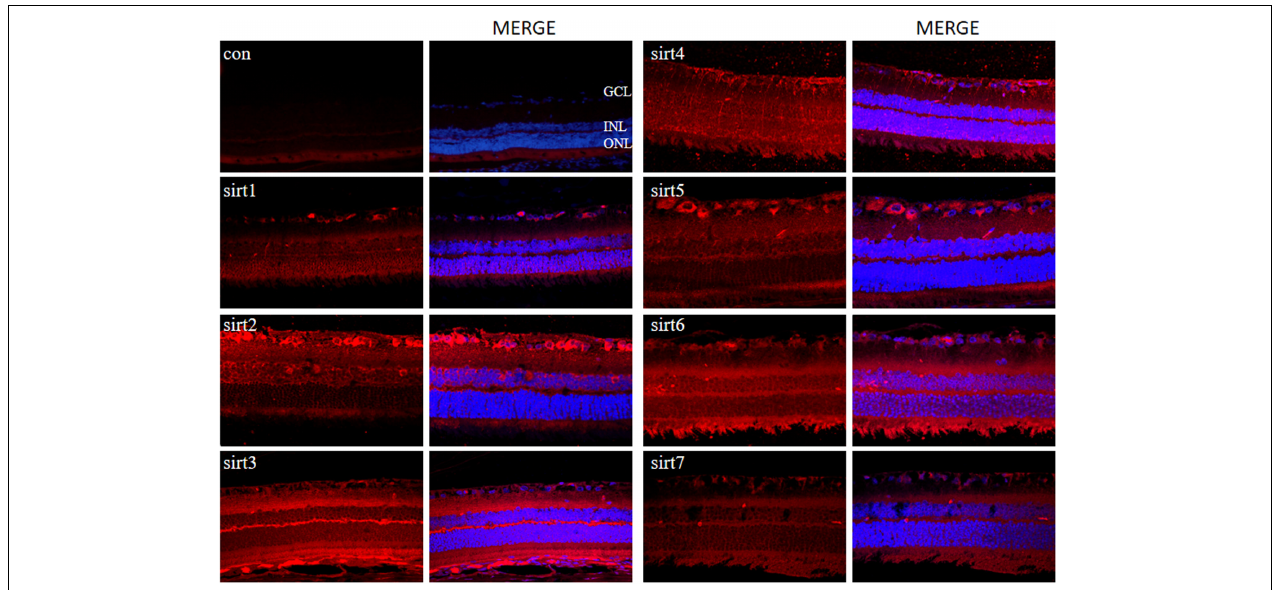
FIGURE 4 | Immunolocalization of Sirtuin proteins in retinal cross-sections of rat. Retinal cross sections prepared from rat eyes were immunostained with Sirtuin antibodies. The results are displayed as negative control (without primary antibody), SIRT1, SIRT2, SIRT3, SIRT4, SIRT5, SIRT6, and SIRT7 in adult rat retinas. All photographs were taken at 40 × magnification. Con, control; GCL, ganglion cell layer; INL, inner nuclear layer; ONL, outer nuclear